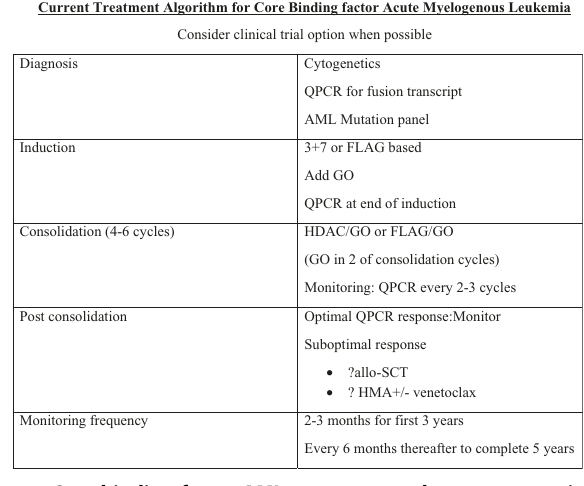
Fig. 1 Core binding factor AML treatment and response monitor- ing algorithm. FLAG fl udarabine, cytarabine, GCSF, HDAC high-dose cytarabine, GO gemtuzumab ozogamicin, QPCR quantitative poly- merase chain reaction, all-SCT allogeneic stem cell transplant, HMA hypomethylating